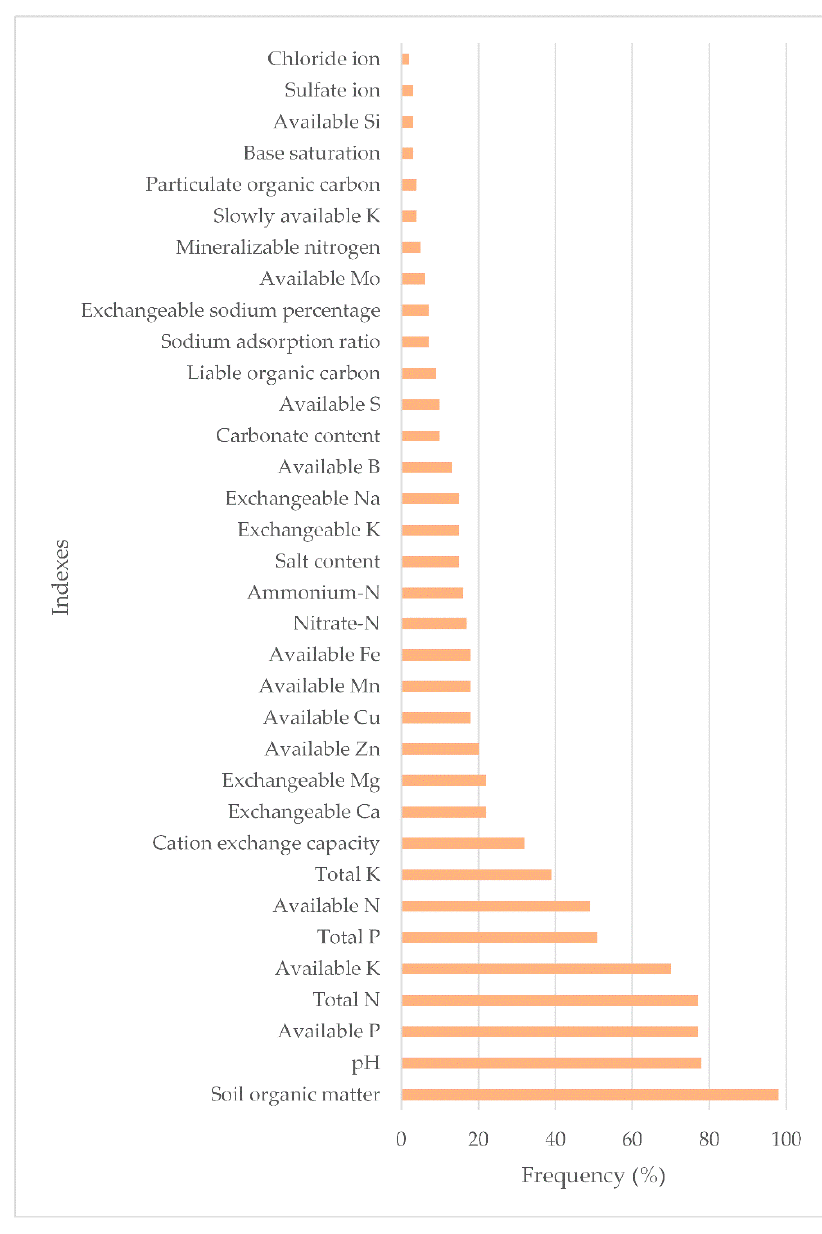
Figure 2. Soil chemistry evaluation indices.